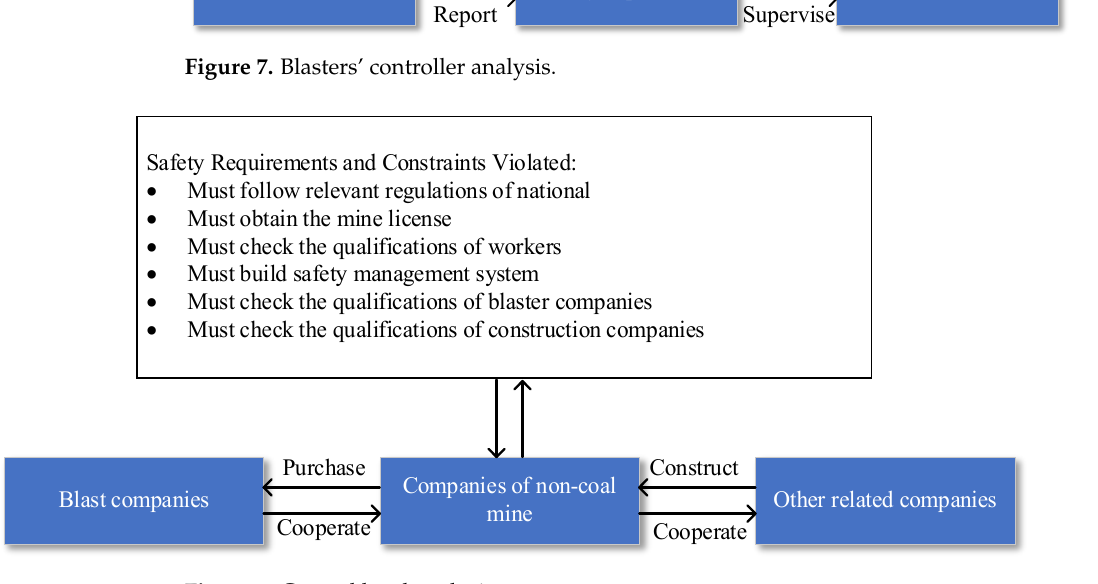
Figure 8. Control level